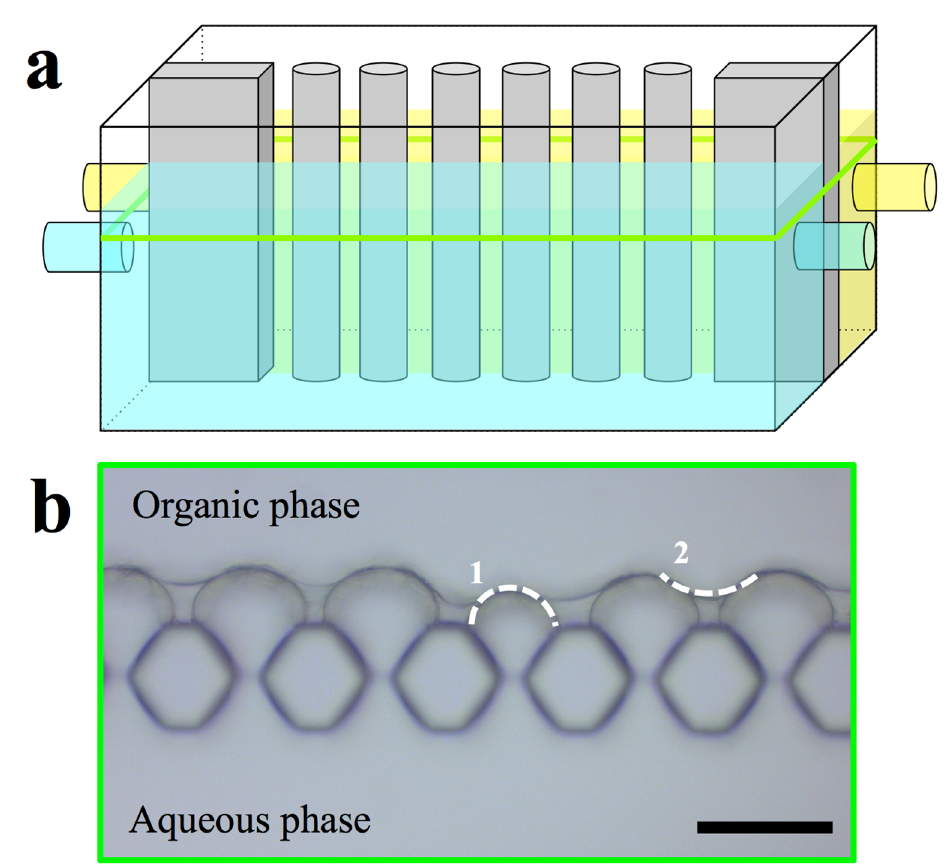
Figure 12. ( a ) Schematic sketch of the microfluidic chamber and micrographs of POSS/proteopolymersomes+TMC AL and ( b ) micrograph of the compartment. The aqueous phase reached into the other compartment. After introducing the organic phase, a well- defined AL formed. Scale bar is 50